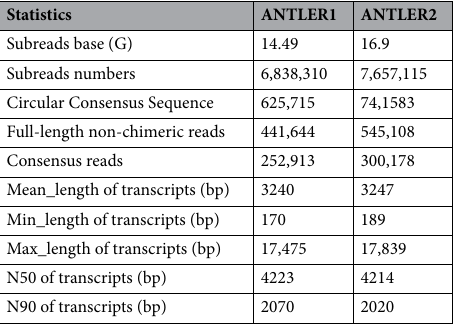
Table 1. Data output using the SMRT sequencing